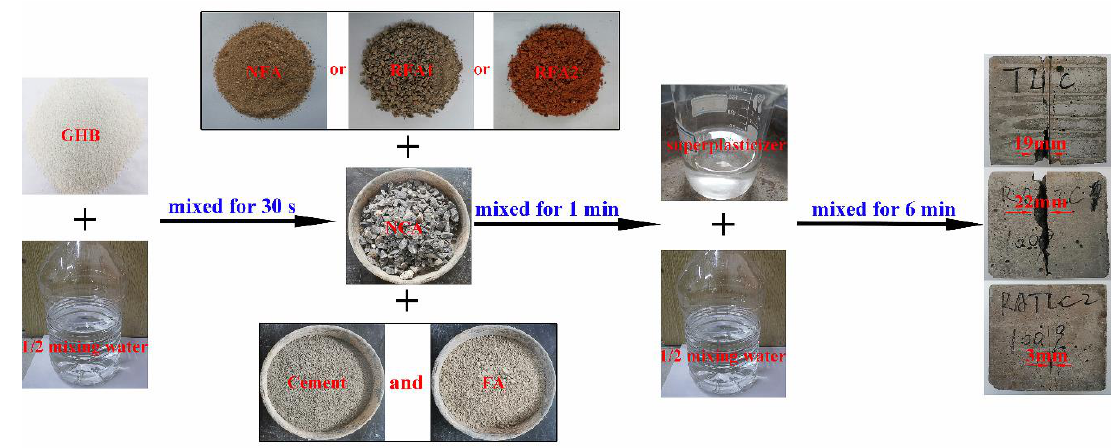
Figure 5. Schematic view of mixing procedures.